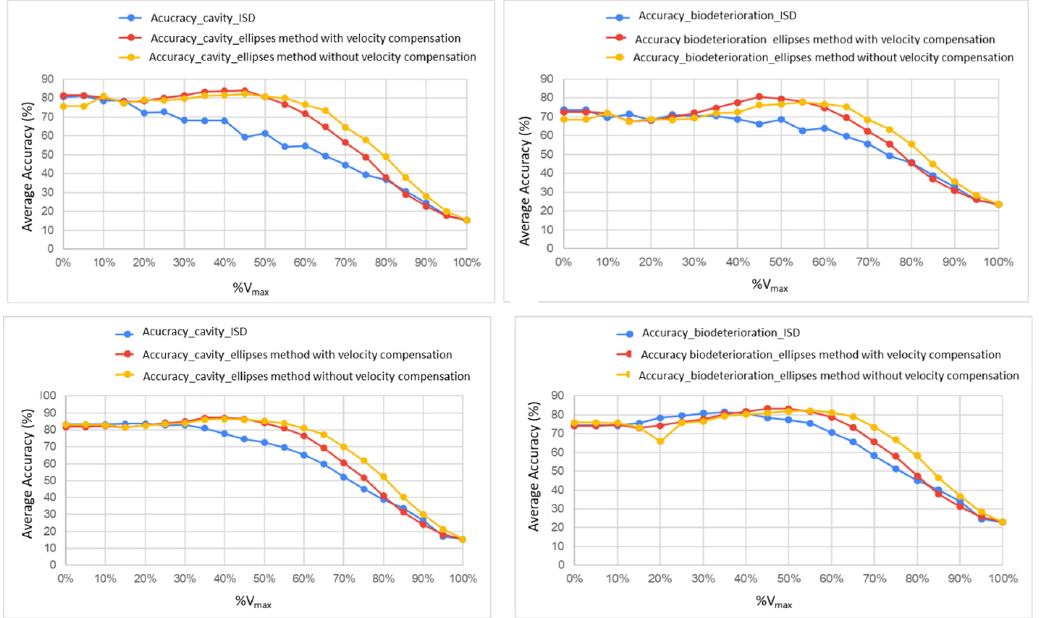
Figure 10. Behavior of the accuracy metric obtained with the application of the confusion matrix for the cavity and the cavity plus biodeterioration as zones of interest, without the application of filters (upper graphs) and with the application of filters (lower graphs).